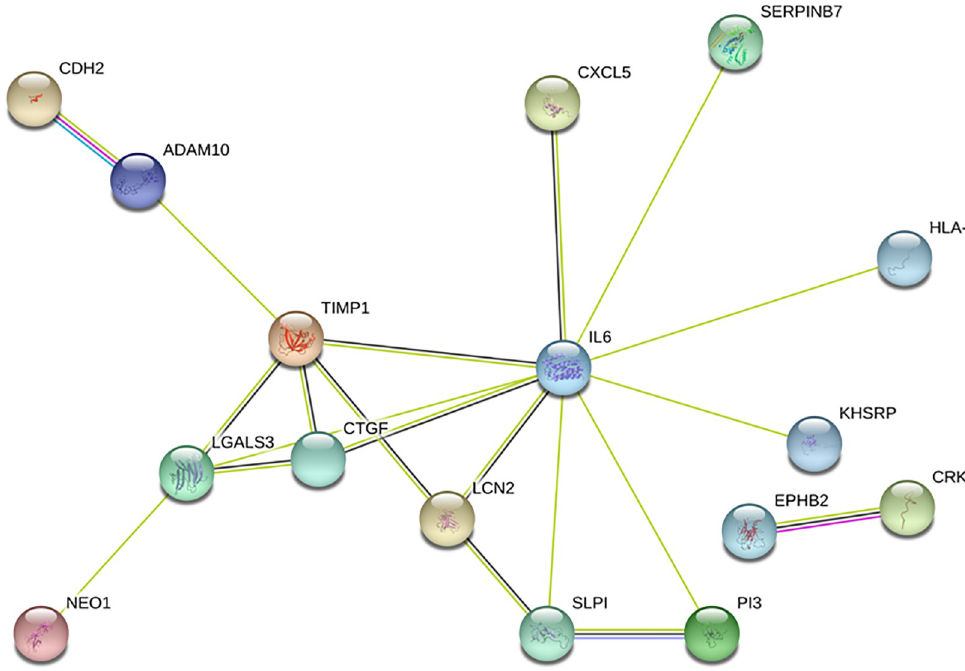
Fig 5. Protein-protein interaction analysis of highly secreted proteins in PC3/nKR cells by STRING.